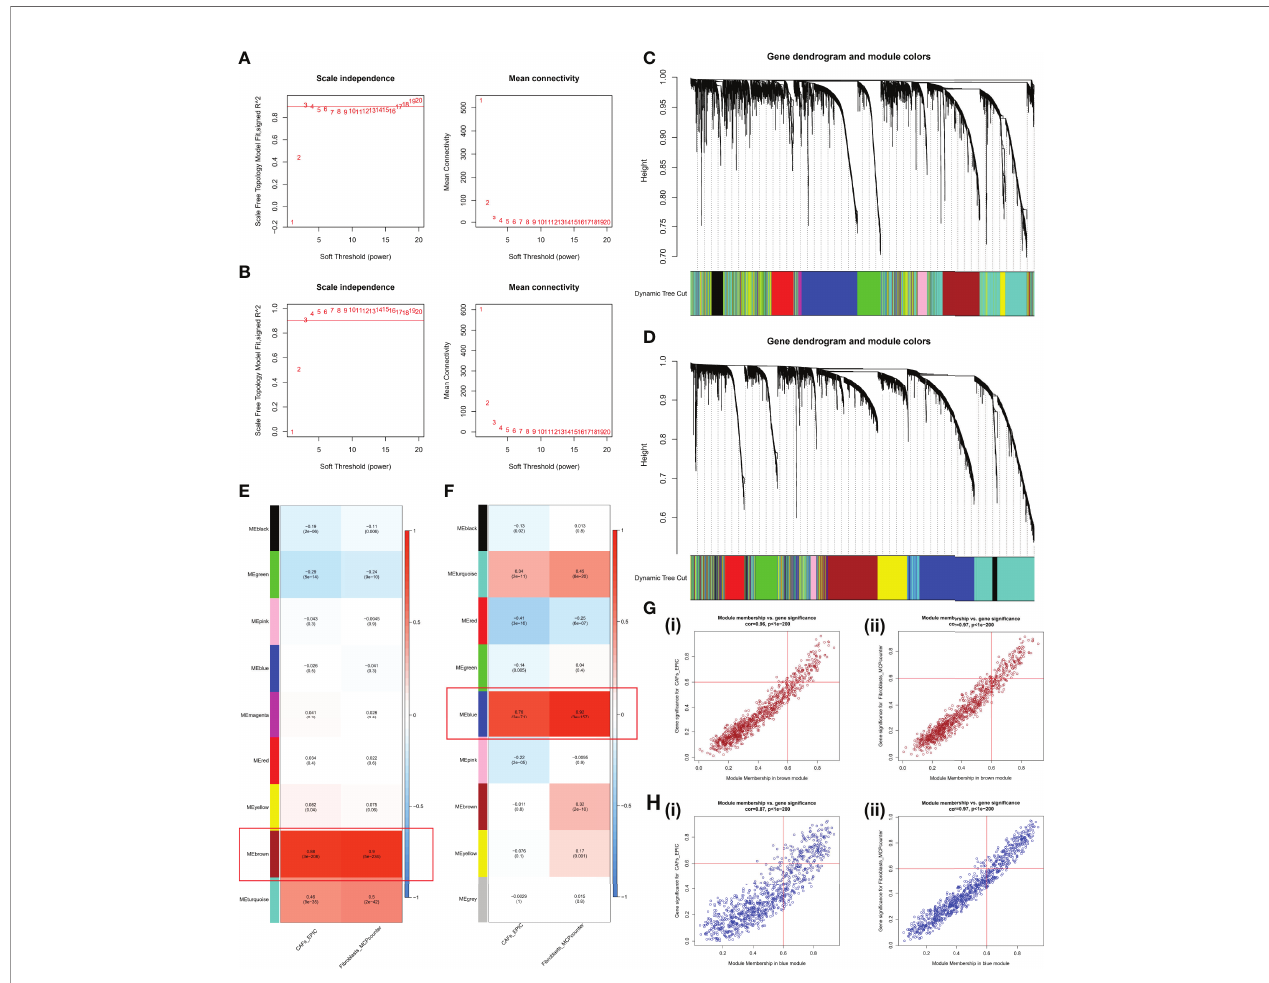
FIGURE 3 | WGCNA in the GPL570 meta-cohort and TCGA-OV cohort. (A) Scale independence and mean connectivity in the GPL570 meta-cohort. (B) Scale independence and mean connectivity in TCGA-OV cohort. (C) Gene dendrogram and modules before merging in the GPL570 meta-cohort. (D) Gene dendrogram and modules before merging in TCGA-OV cohort. (E) Pearson correlation analysis of merged modules and CAF score in the GPL570 meta-cohort. (F) Pearson correlation analysis of merged modules and CAF score in TCGA-OV cohort. (G) Scatterplot of MM and GS from the brown module in the GPL570 meta-cohort, including CAFs_EPIC (i) and Fibroblasts_MCPcounter (ii). (H) Scatterplot of MM and GS from the blue module in TCGA-OV cohort, including CAFs_EPIC (i) and Fibroblasts_MCPcounter (ii). WGCNA, Weighted Gene Co-expression Network Analysis; CAFs, Cancer-Associated Fibroblasts; GS, Gene Signi fi cance; MM, Module